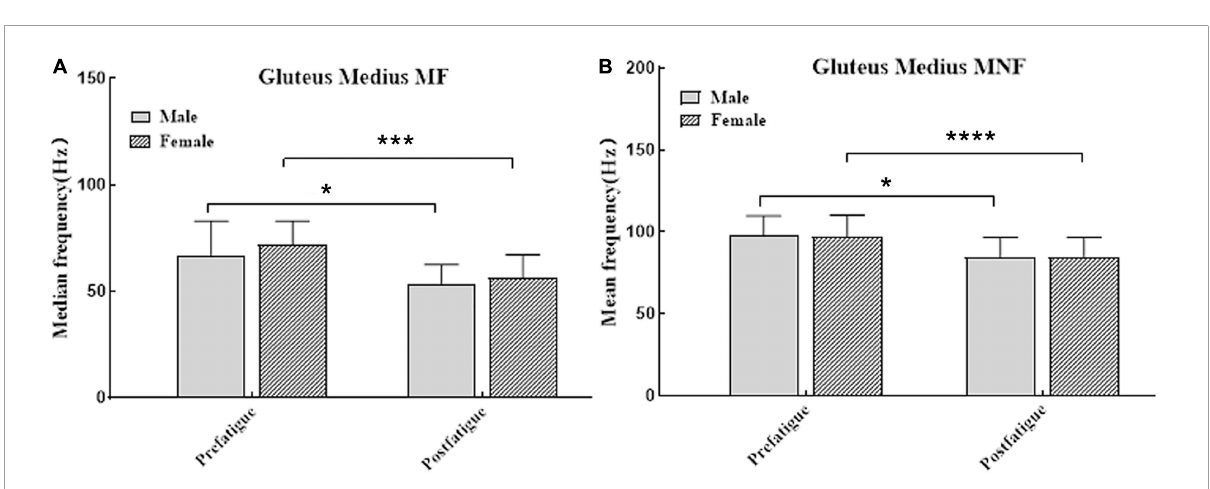
FIGURE4 (A) The median frequency (mean and standard error) were significantly different after fatigue in men (dark bars) and women (bar with oblique line). (B) The mean frequency (mean and standard error) were significantly different after fatigue in men (dark bars) and women (bar with oblique line). * P < 0.05, *** P < 0.001, and **** P <